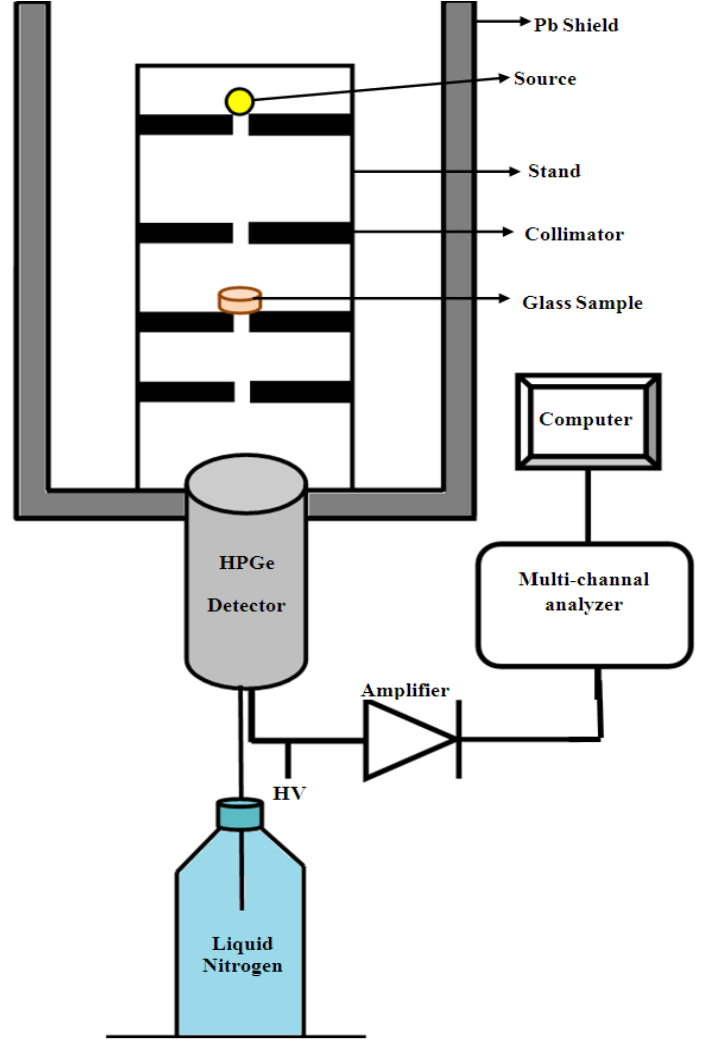
Figure 1. The schematic diagram of the setup used for the determination of the attenuation coeffi-